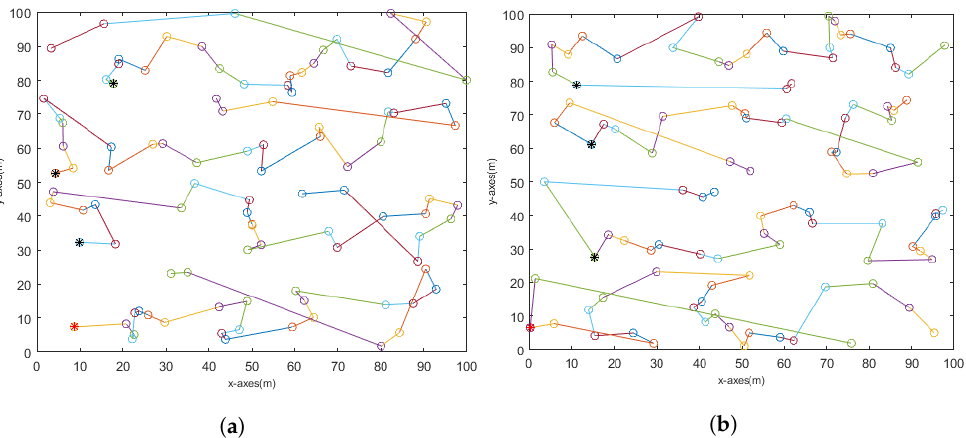
Figure 18. Multi-chain multi-hop formation: (nodes are depicted using a range of colors, whereas the CH is symbolized by (cid:107) and the LN is symbolized by (cid:107) ). ( a ) D-Chain, ( b )